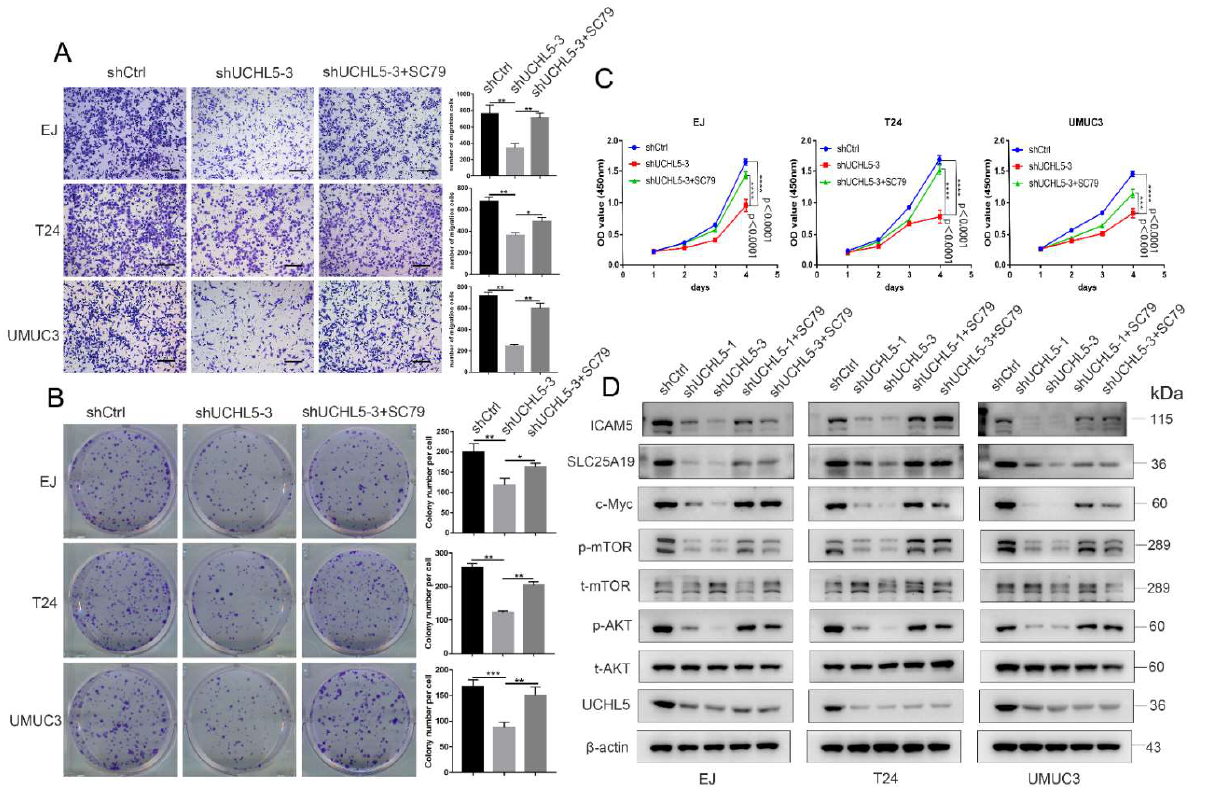
Figure 5. SC79 recovers the effect of UCHL5 knockdown in bladder cancer cells. ( A ) Transwell assay (Scale bar = 200μm) assessment of cell migration in shCtrl, shUCHL5-3, and shUCHL5-3 + SC79 groups. ( B , C ) Cell proliferation of three groups evaluated using CCK-8 and colony formation assays. ( D ) Western blotting analysis of the p-AKT, t-AKT, p-mTOR, t-mTOR, c-Myc, SLC25A19, and ICAM5 protein expression in bladder cancer cells. β-Actin is used as the loading control. Values are shown as mean ± SD. * p < 0.05, ** p < 0.01, *** p <0.001, and **** p < 0.0001 compared with controls.